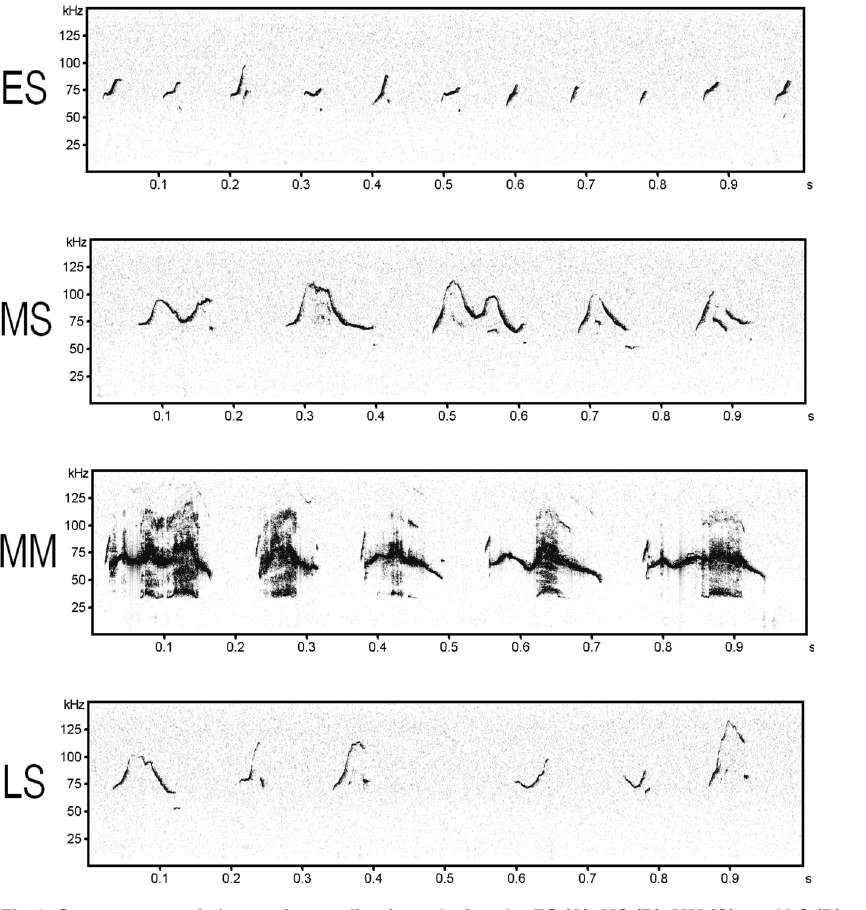
Fig 4. Spectrogram of ultrasonic vocalizations during the ES (A), MS (B), MM (C), and LS (D).